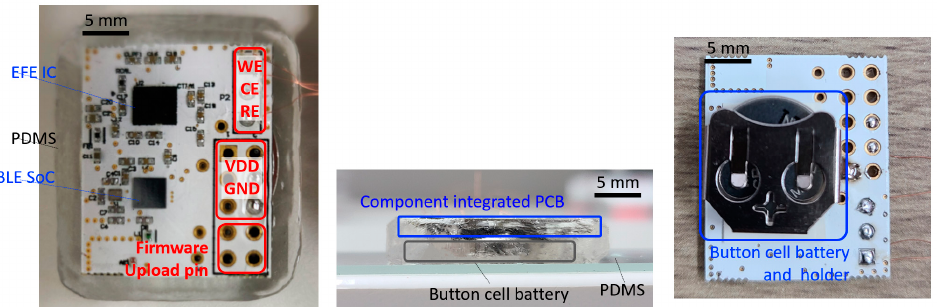
Figure 1. Image of the wireless glucose monitoring device. Top, side view of the PDMS packaged device and bottom view of the device with a battery holder.